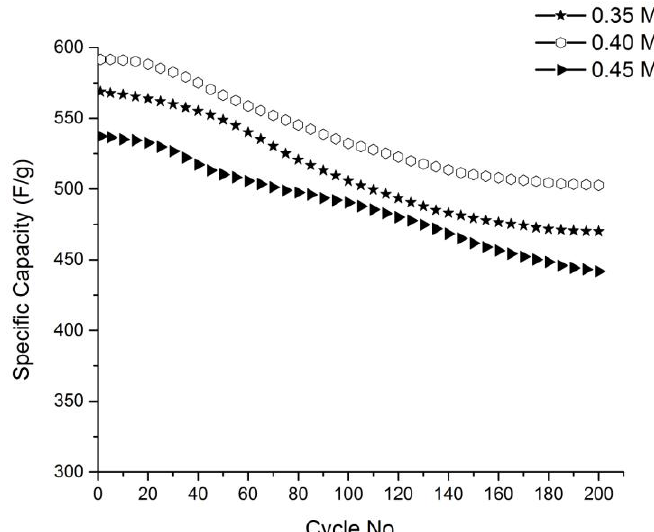
Figure 4: Specific capacity variation of PANI redox capacitors having aniline concentration of 0.35 M, 0.40 M and 0.45 M obtained from cyclic voltammograms.